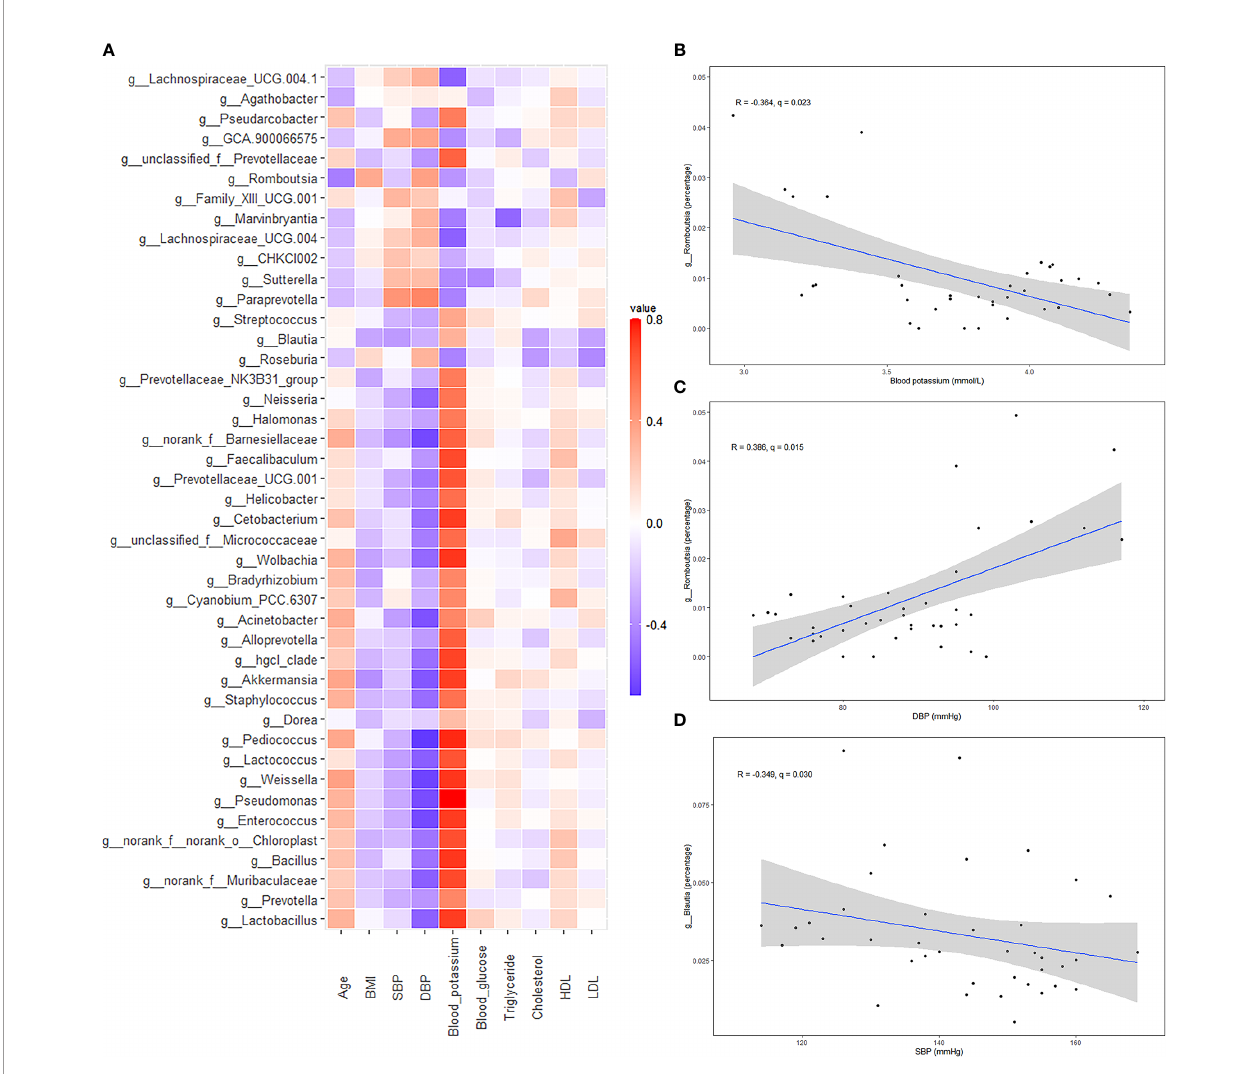
FIGURE 6 | Spearman correlation analysis of different bacteria [primary aldosteronism (PA) patients vs. primary hypertension patients] and clinical characteristics. (A) Heatmap showing the correlation between different bacteria and clinical characteristics. (B) Scatter plot graphs showing the correlation between blood potassium and Romboutsia . (C) Scatter plot graphs showing the correlation between diastolic blood pressure (DBP) and Romboutsia . (D) Scatter plot graphs showing the correlation between systolic blood pressure (SBP) and Blautia